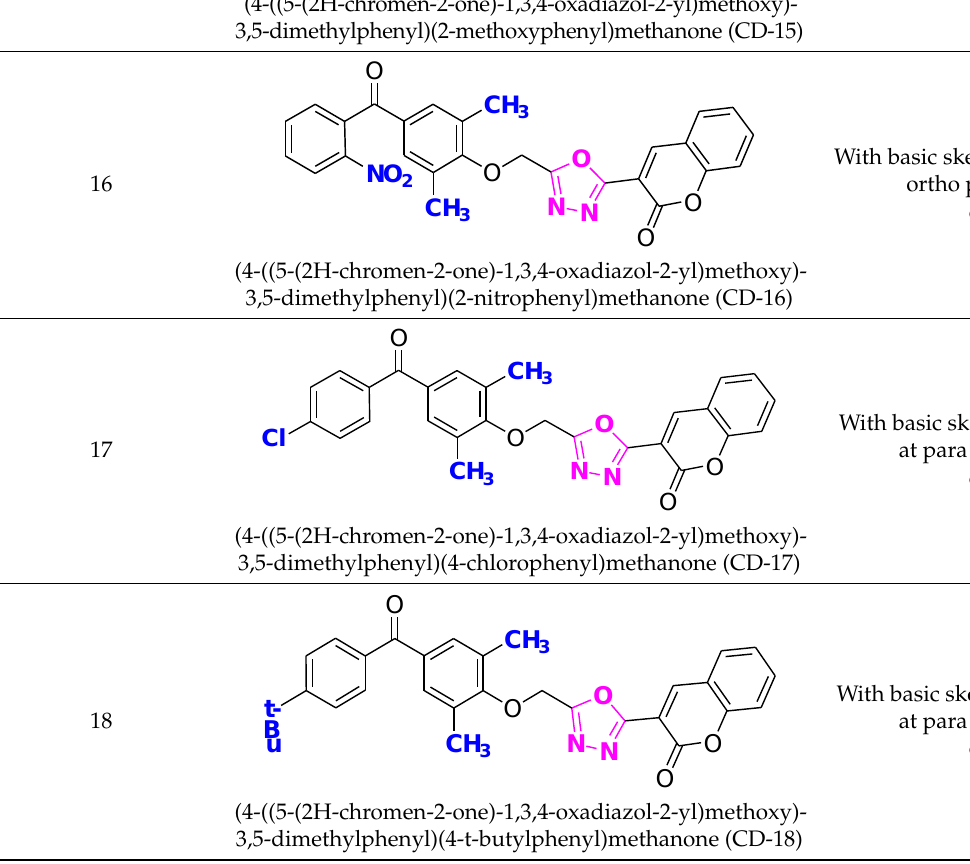
3,5-dimethylphenyl)(2-methoxyphenyl)methanone (CD-15)